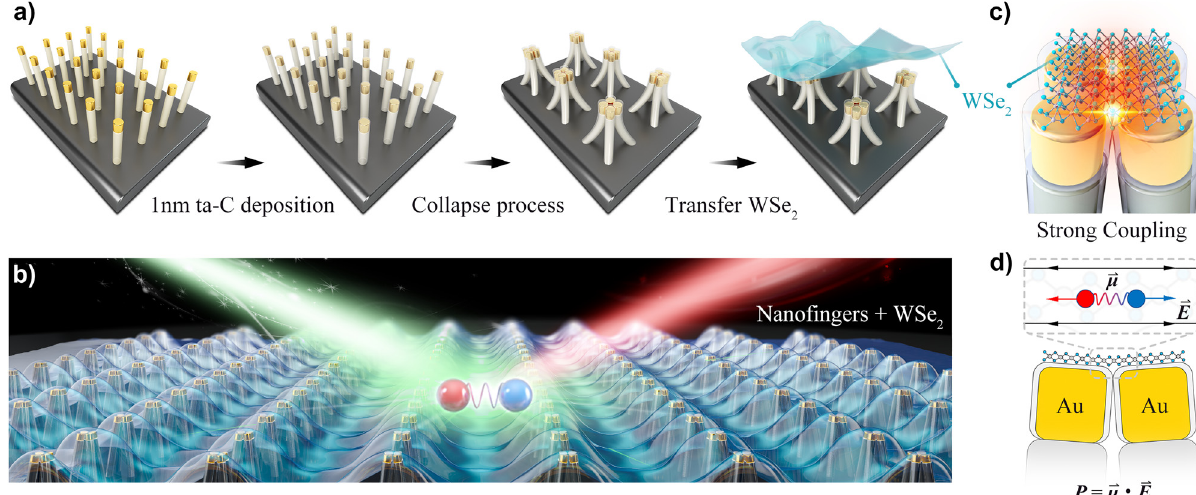
Figure 1: In-plane exciton – plasmon polaritons in monolayer WSe 2 driven by plasmonic nano fi ngers. (a)SchematicoffabricationprocessofmonolayerWSe 2 onplasmonicnano fi ngerarrays.(b)Strongcouplingsystemwithnano fi ngertetramers underamonolayerWSe 2 , inwhichthe redandbluespheresrepresentforthe in-planeexcitons.(c) Strongspilling-out plasmonicelectric fi eld in free space generated by the ultrathin ta-C fi lm coated nano fi ngers. (d) Strong interaction between the coupled plasmons and in-plane